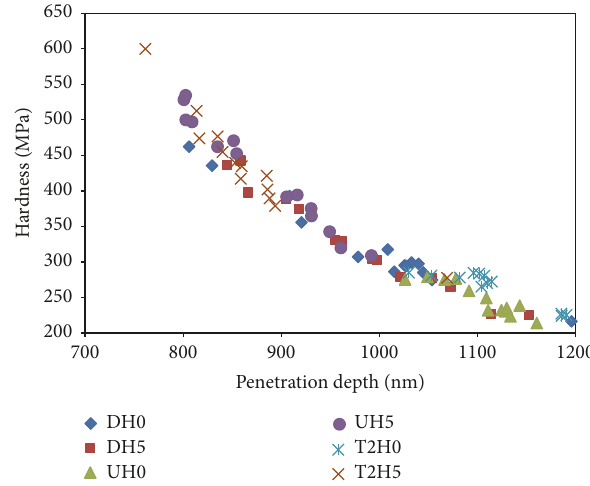
Figure 6: Hardness versus penetration depth for POM and POM/HAp